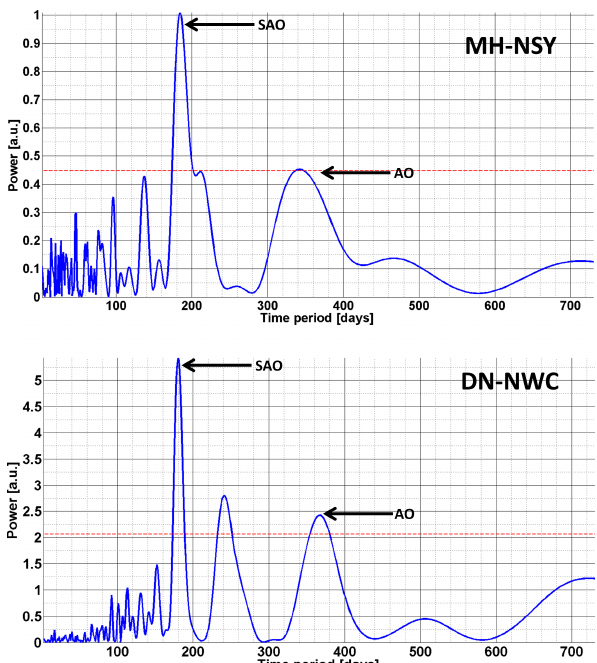
Figure 3. Lomb–Scargle periodogram of the midnight MH-NSY (top) and DN-NWC (bottom) GCP 1h mean VLF amplitude anomalies in arbitrary power units. The dashed red line denotes the 95% confidence